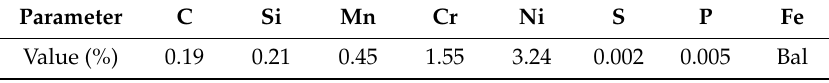
Table 1. Chemical component of 20Cr2Ni4A alloy steel.